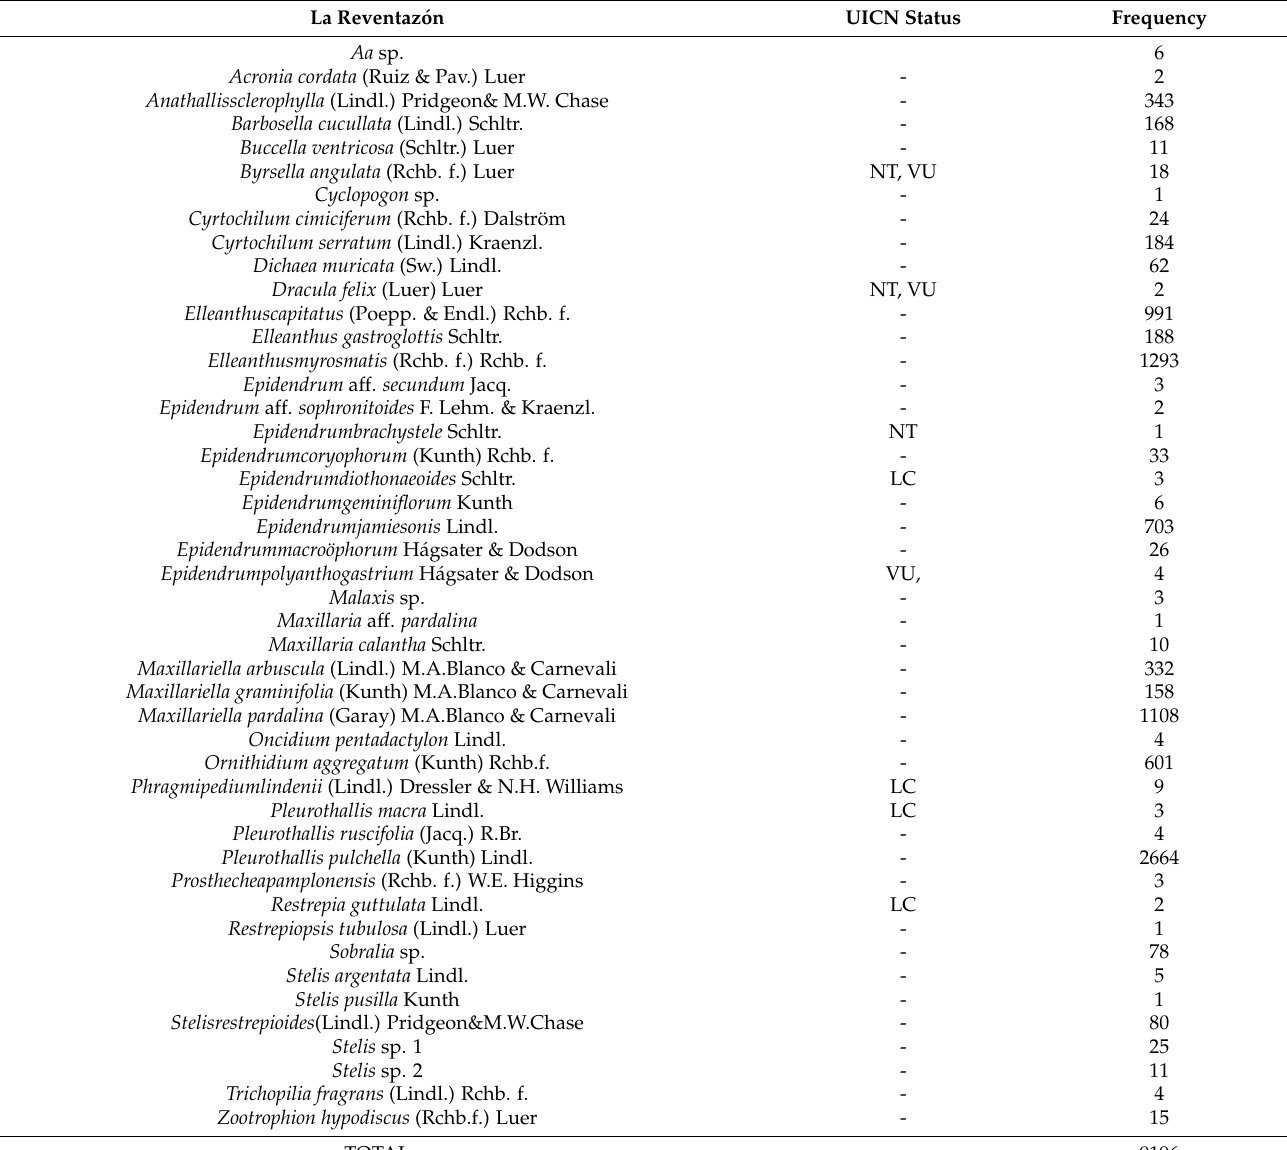
Table A2. List of species in the La Reventaz ó n